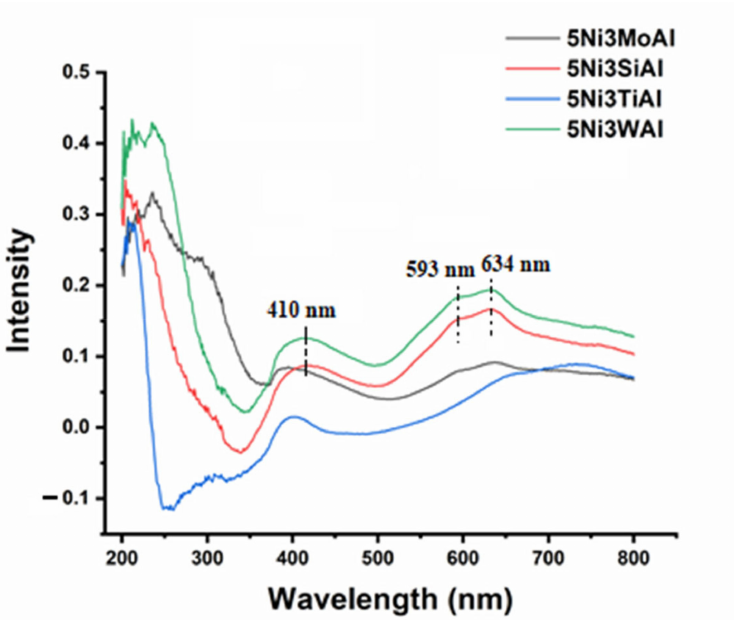
Figure 4. Ultraviolet–visible spectra of different catalyst systems. Peak at 410 nm is associated with d–d transition 3 A 2g (F) → 3 T 1g (P) in Ni 2+ in an octahedral environment. Peaks at 593 and 634 nm